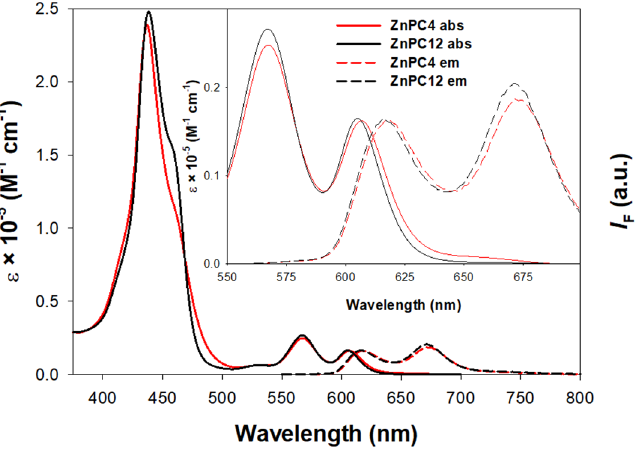
Figure 2. ε -normalized absorption spectra and normalized emission spectra (1 µM conc., λ exc . = 445 nm) of ZnPC4 and ZnPC12 in THF solution.